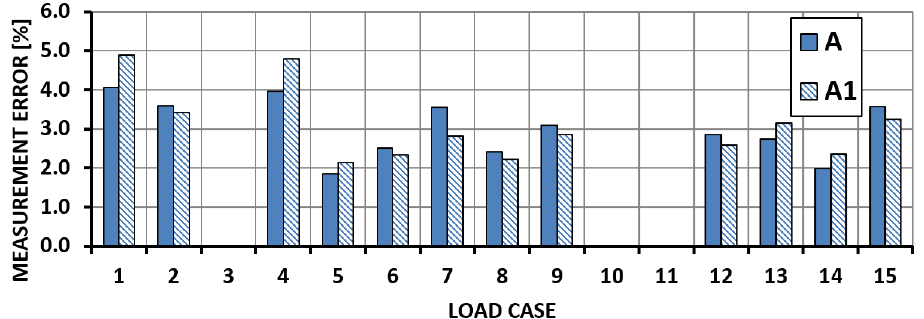
Figure 12. Shear force measurement error—Section II.